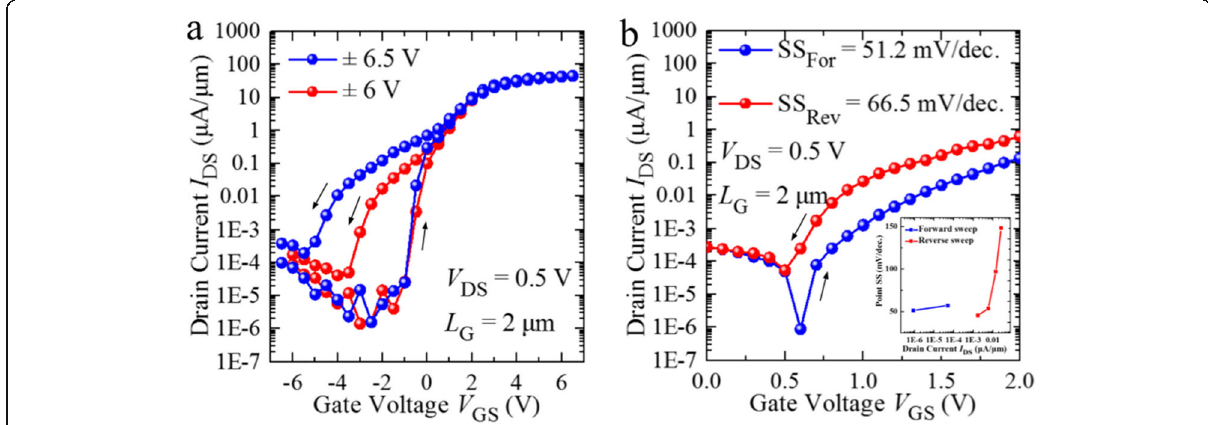
Fig. 3 The direct current (DC) test of the HZO/MoS 2 FeFET when drain voltage ( V DS ) is 0.5 V. a The comparison between transfer curves with 6 V and 6.5 V as maximum of the back gate voltage. b Enlarged view of transfer curves at 0 to − 2 V interval of V GS,range = ( − 3, 3 V). Point subthreshold slope (SS) as a function of drain current ( I DS ) of the HZO/MoS 2 FeFET is ( b ) inset. The device exhibits SS For = 51.2